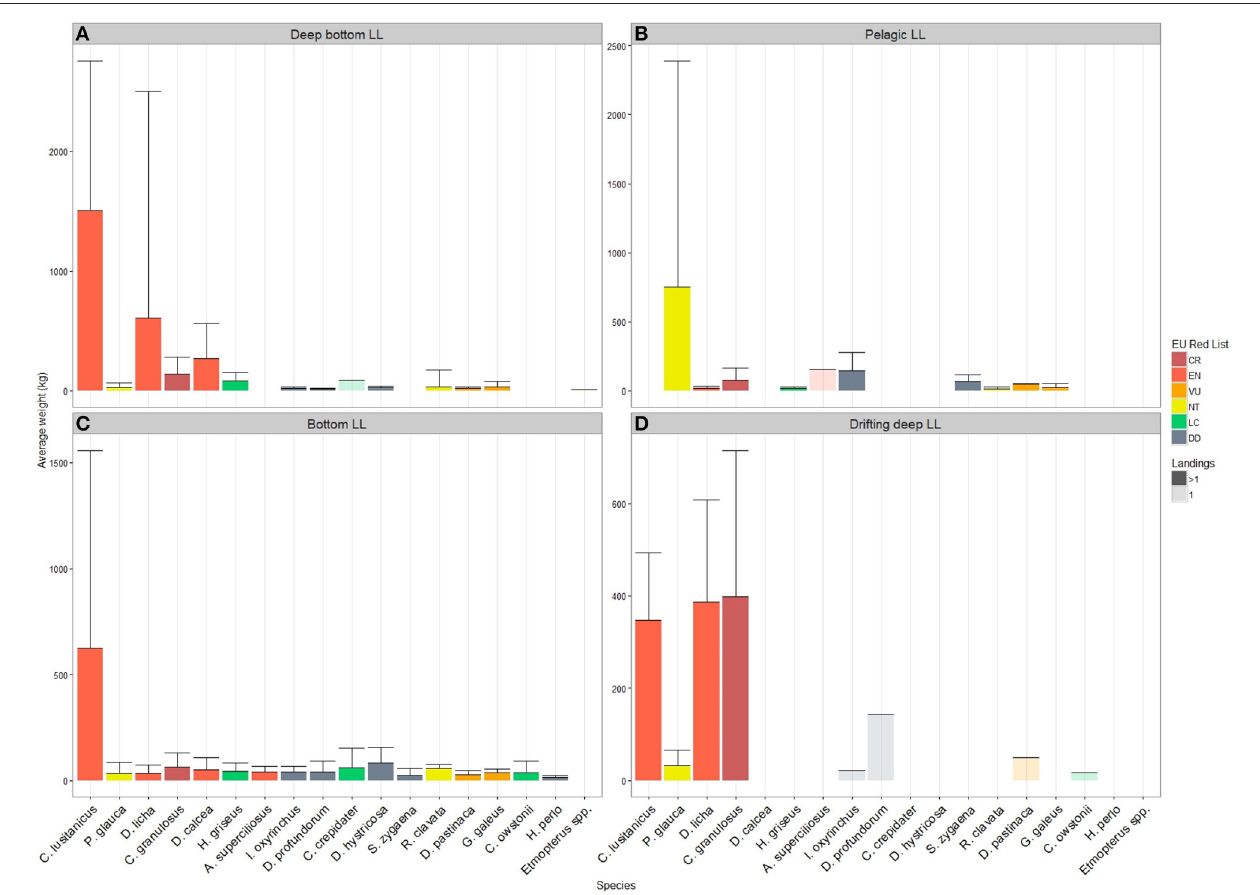
FIGURE 6 | Species composition, by regional Red List status, and average weight per landing of métiers using longlines; semi-transparent bars for species with only one landing record. NB, Y-axis different for each panel. (A) Deep bottom longline, (B) Pelagic longline, (C) Bottom longline, (D) Drifting bottom longline.